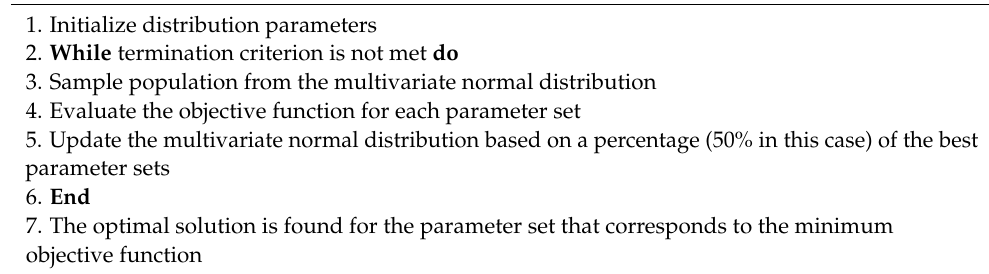
Algorithm 1. Main steps of CMA–ES